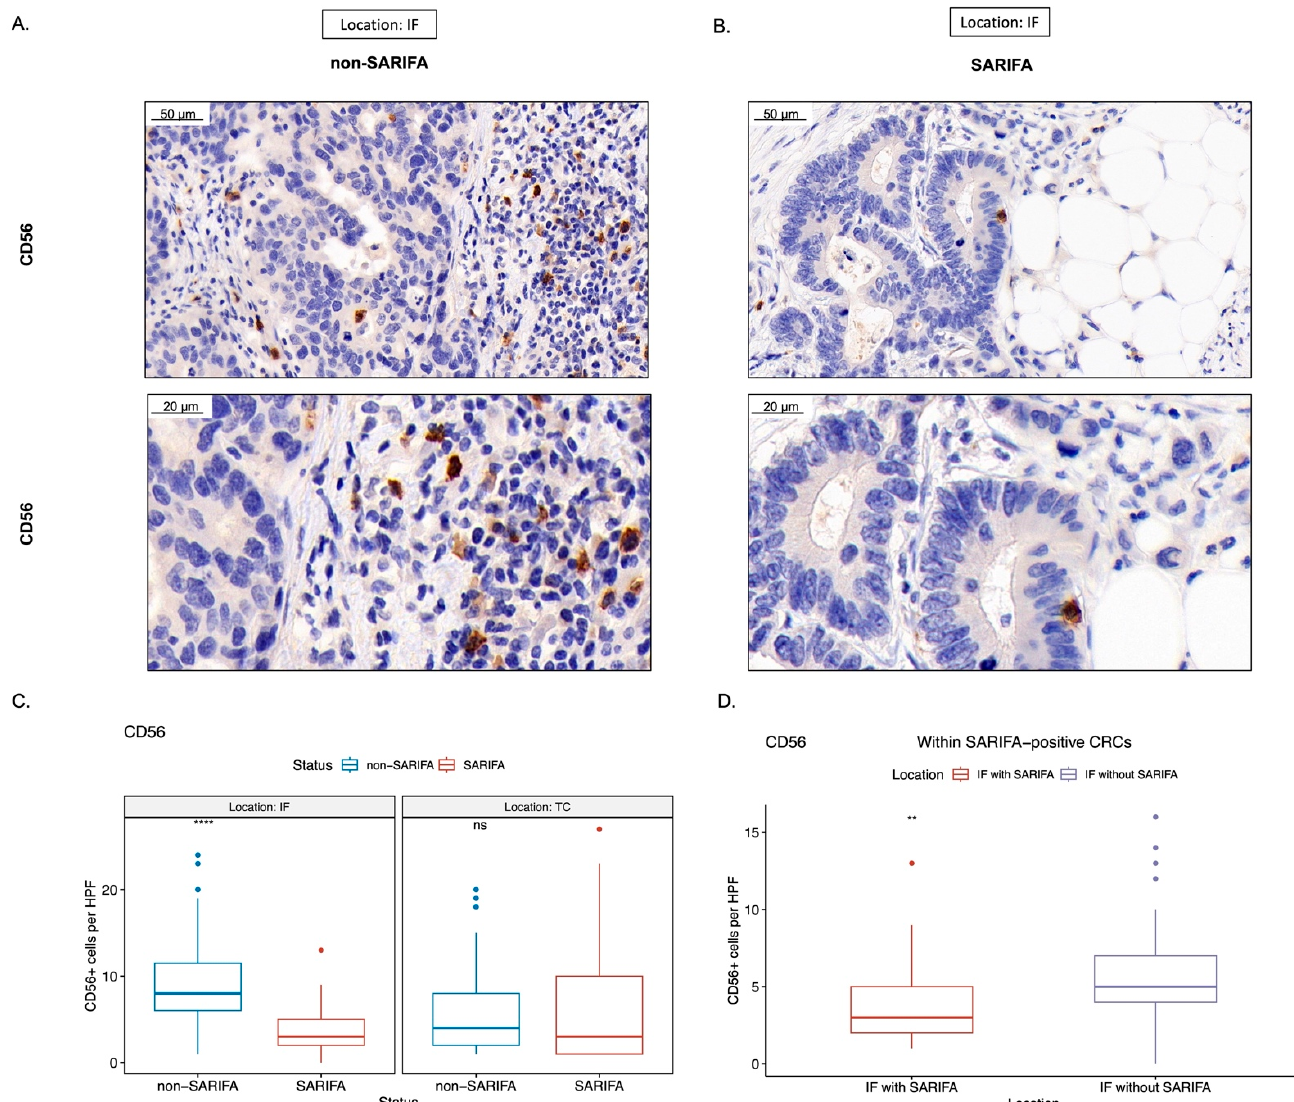
Figure 4. Representative immunohistochemical stains for CD56 ( A and B ; scale bar = 50 µm and 20 µm, respectively). Boxplots showing the amount of CD56+ lymphocytes per high-power field (HPF, 400×), comparing between SARIFA-positive (SARIFA) and SARIFA-negative CRCs (non-SARIFA) at IF and TC ( C ) and comparing SARIFAs vs. non-SARIFAs, only within SARIFA-positive CRCs ( D ) as SARIFA-positive CRCs also show non-SARIFAs at the invasive margin (see Figure 1E). ns = not significant ( p < 0.05). ** for p < 0.01, **** for p < 0.0001.